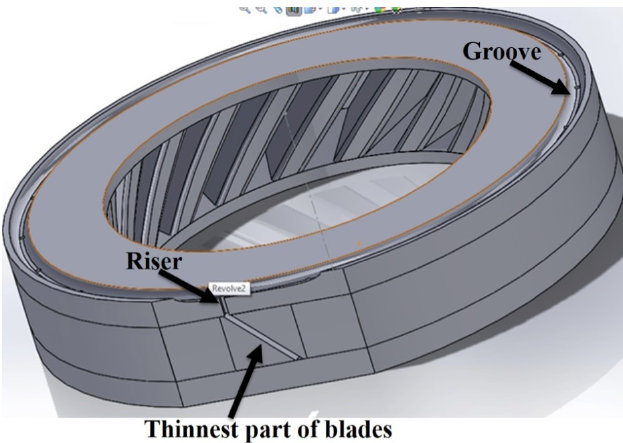
Figure 6. CAD model of the final version of the simple ‘over can’ design.